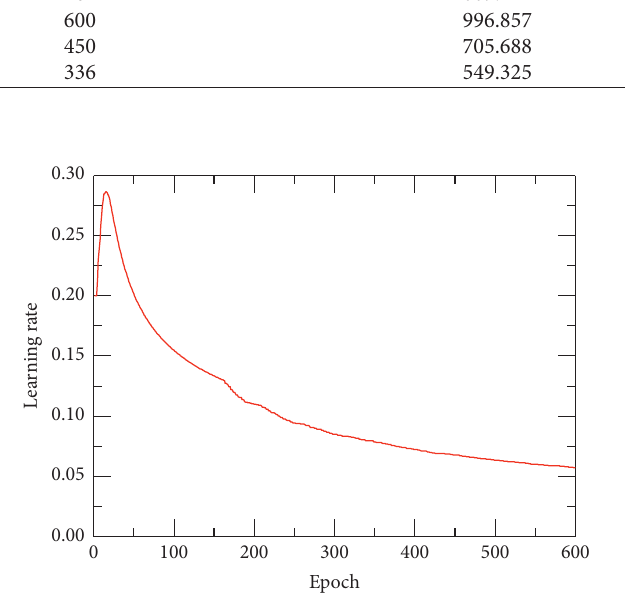
Figure 8: Dynamic learning rate curve.